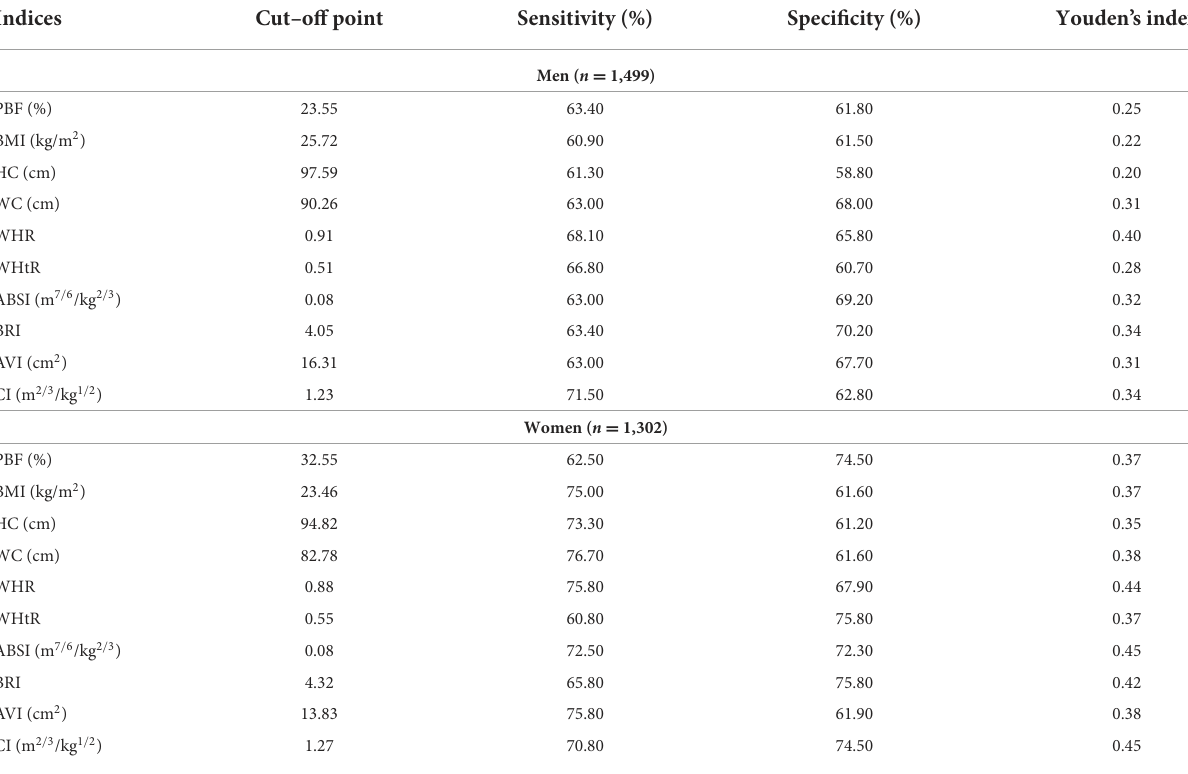
TABLE 5 The optimal cut points of 10 types of ORI for predicting hypertension.